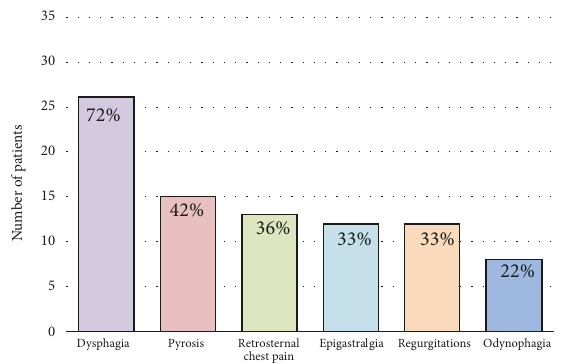
Figure 3: Symptoms of the patients diagnosed with Jackhammer esophagus. The percentages in each column indicate the proportion of patients having the